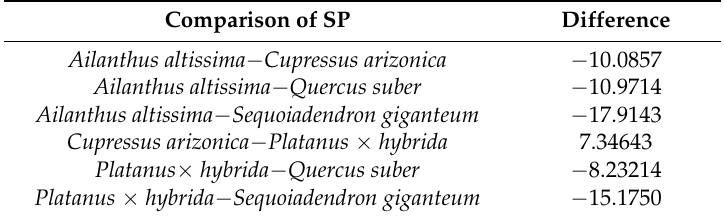
Table 8. Significant results of the multiple range test (LSD) for %S according to SP.